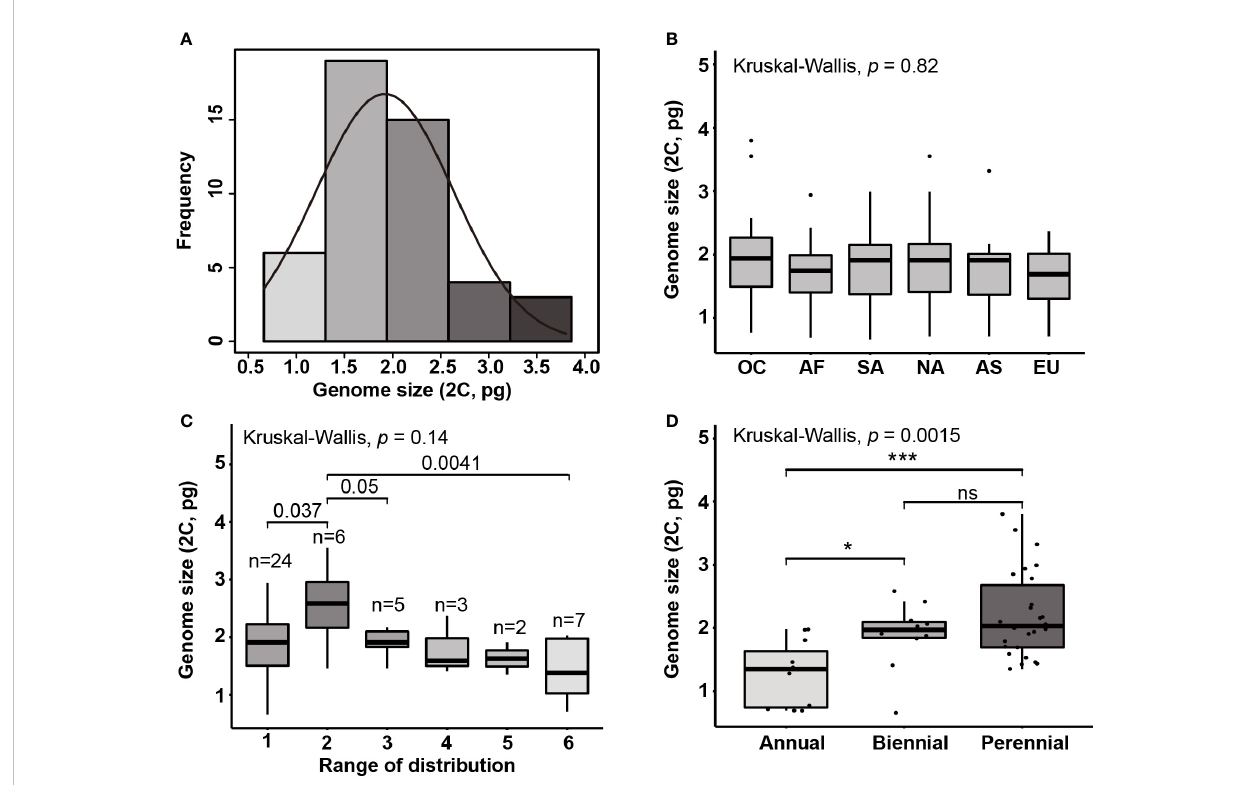
FIGURE 2 (A) Histogram of genome sizes (2C; pg) in Eragrostis and the normal density curve. Boxplots show the genome size variation on (B) six continents (C) range of distribution (occupied continents) and (D) life styles. The value of occupied continents corresponding to species occurred in one continent to six continents, according to the distribution data from GBIF. OC, Oceania; AF, Africa; SA, South America; NA, North America; AS, Asia; EU, Europe. Ns, not statistically signi fi cant; ***, p < 0.001; *, p <